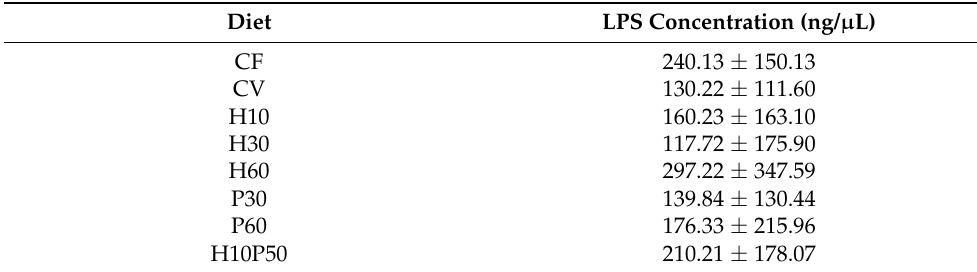
Table 3. Plasma LPS concentration (ng/ µ L), mean ± standard deviation